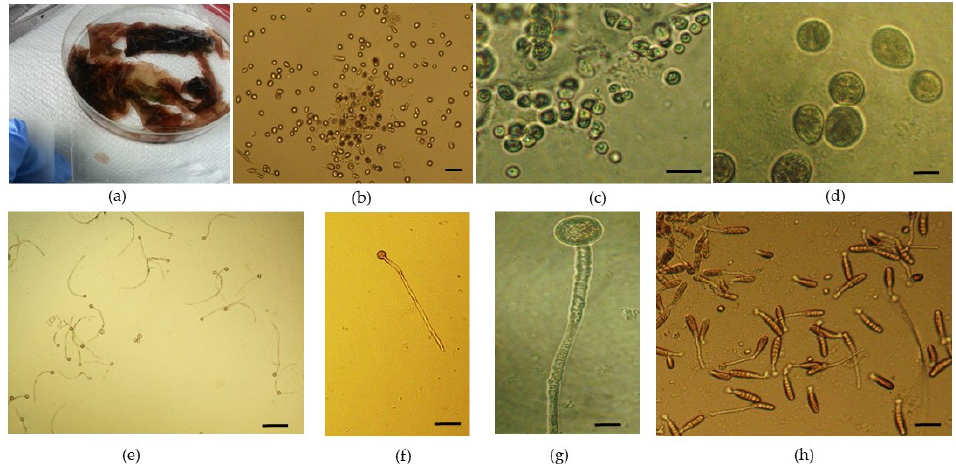
Figure 1. ( a ) Wild blades and a fragment of the reproductive tissue; ( b ) mass release of neutral spores (scale bar: 200 µ m); ( c ) agglomeration of neutral spores (scale bar: 100 µ m); ( d ) details of neutral (scale bar: 200 μ m); ( c ) agglomeration of neutral spores (scale bar: 100 μ m); ( d ) details of neutral spores (scale bar: 20 μ m); ( e ) development of germinated spores (scale bar: 200 μ m); ( f , g ) details of spores (scale bar: 20 µ m); ( e ) development of germinated spores (scale bar: 200 µ m); ( f , g ) details of a a germinated spore with a germ tube (scale bar: 200 μ m ( f ) and 20 μ m ( g )); ( h ) neutral spore germling germinated spore with a germ tube (scale bar: 200 µ m ( f ) and 20 µ m ( g )); ( h ) neutral spore germling (scale bar: 200 μ m). (scale bar: 200 µ m).